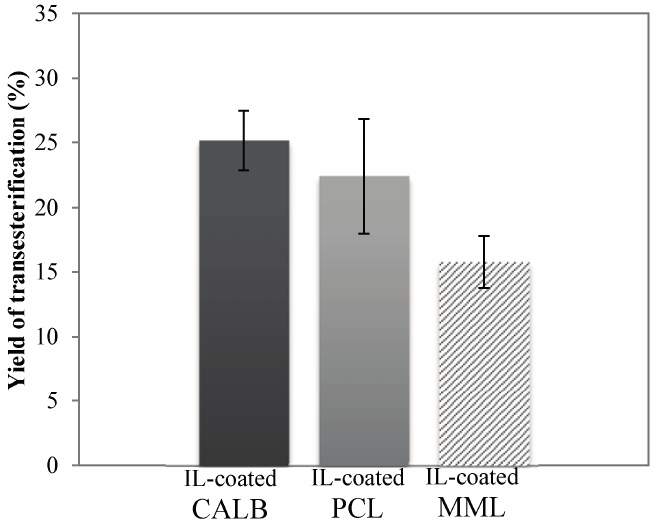
Figure 3. Yield of Kraft lignin transesterification with ethyl oleate (0.24 M) as acyl donor at 48 h catalyzed by the [C 4 C 1 mim][PF 6 ]-coated immobilized lipase B from Candida antarctica (IL-coated CALB) in black bar, the [C 4 C 1 mim][PF 6 ]-coated immobilized lipase from Pseudomonas cepacia (IL-coated PCL) in grey bar and the [C 4 C 1 mim][PF 6 ]-coated immobilized lipase from Mucor miehei (IL-coated MML) in striped bar in [C 4 C 1 mim][OTf] as solvent at 55